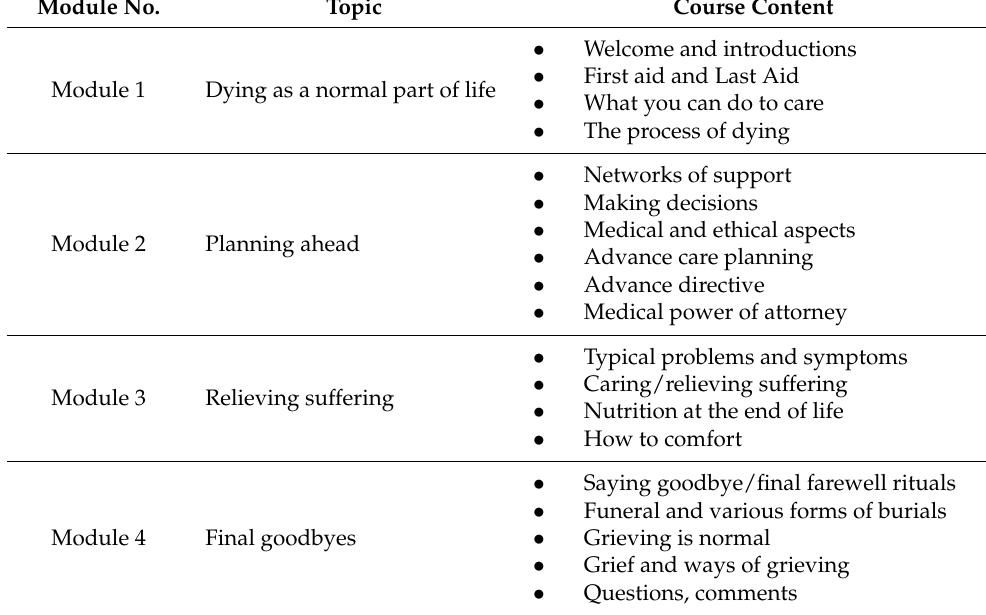
Table 1. The Last Aid course contents. Module